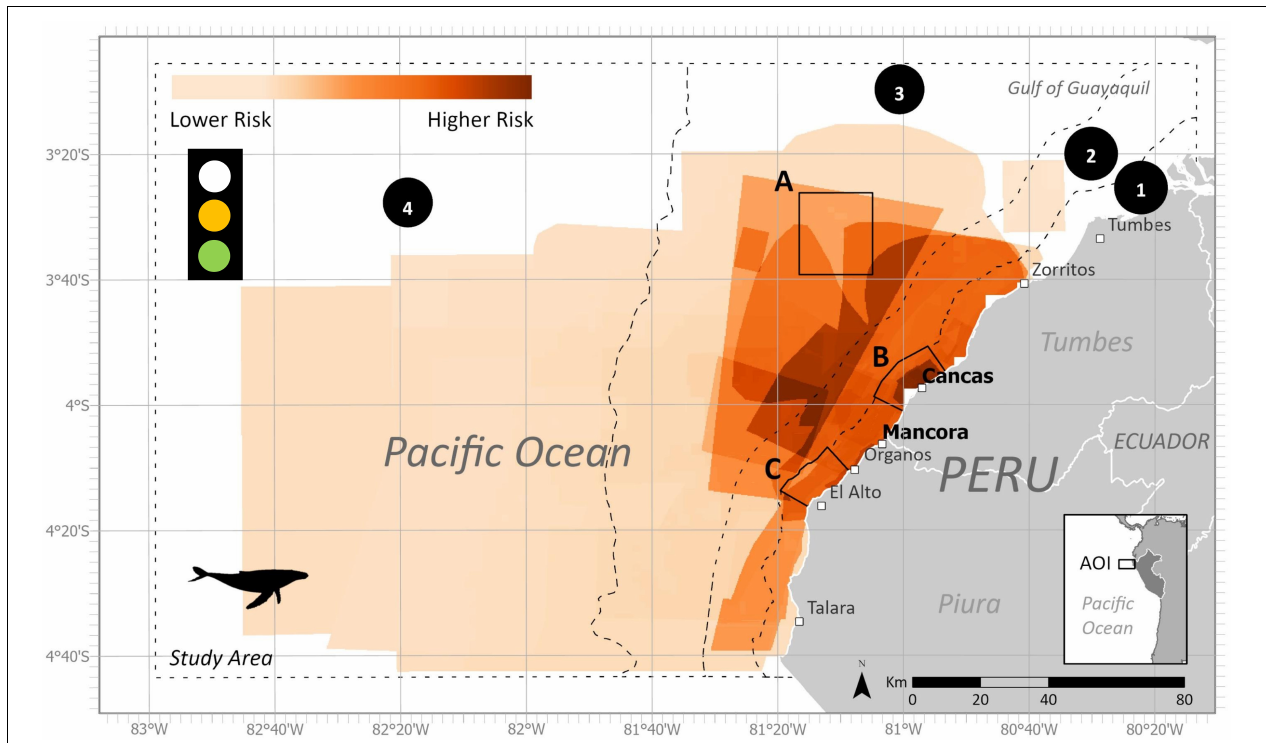
FIGURE 8 | Final estimated bycatch risk within the study area and subzones for humpback whales during the austral winter (June-November). This model output included fishing polygons from both ports. Subzones are represented by black dotted and solid lines. (1) Artisanal fishing zone (5 nm), (2) Territorial seas zone (12 nm), (3) Shelf zone, (4) Beyond shelf zone, (A) Banco de Mancora, (B) Arrecifes de Punta Sal, and (C) Cabo Blanco–El Ñuro. Data uncertainty depicted in stoplight and described further in Table 3